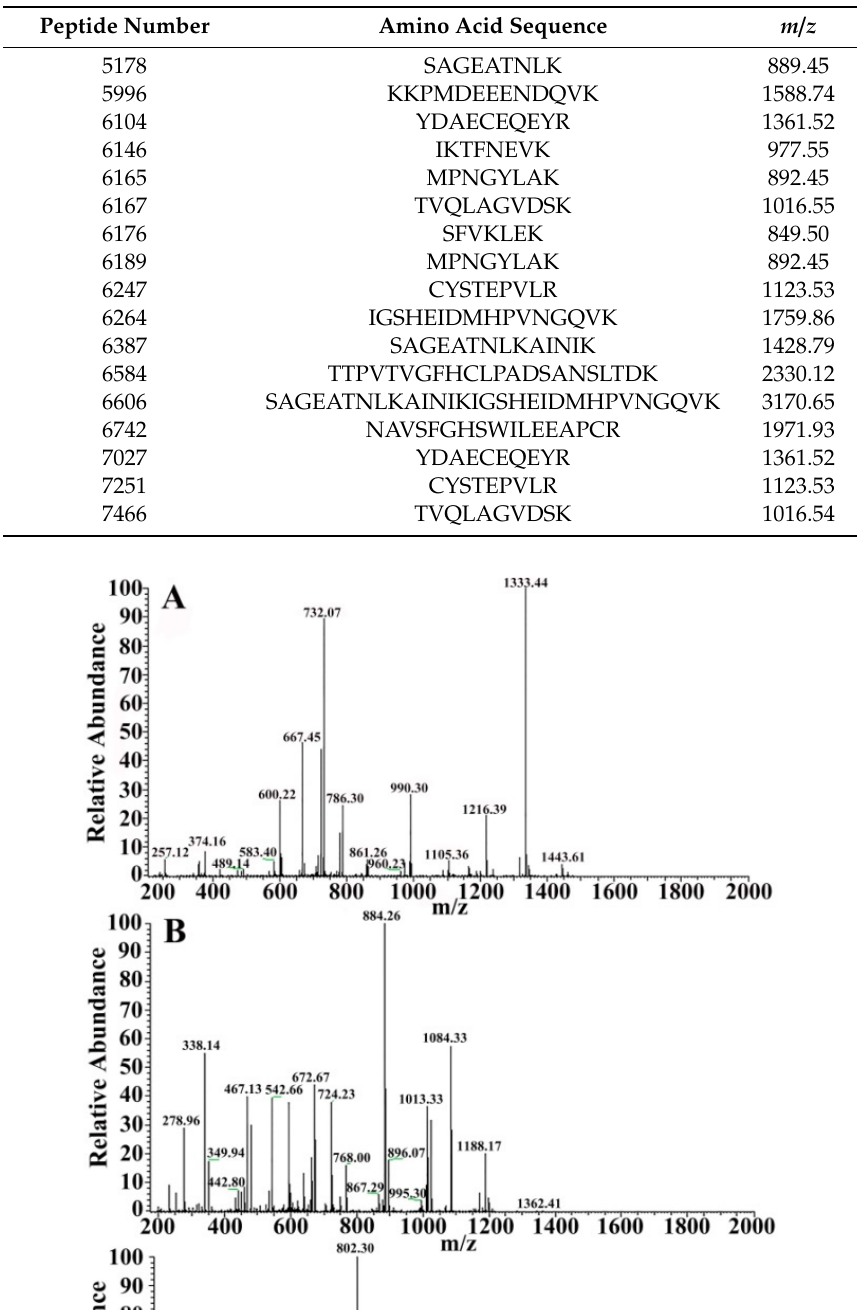
Table 6. The peptides of the VIT2 by Nano LC-ESI-MS/MS.